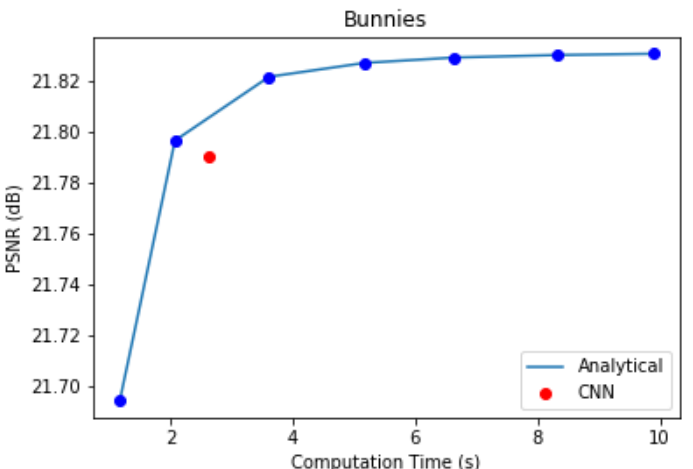
Figure 15. Computation time and accuracy of reproduced light fields using analytical and CNN-based optimization of multiplicative layers.